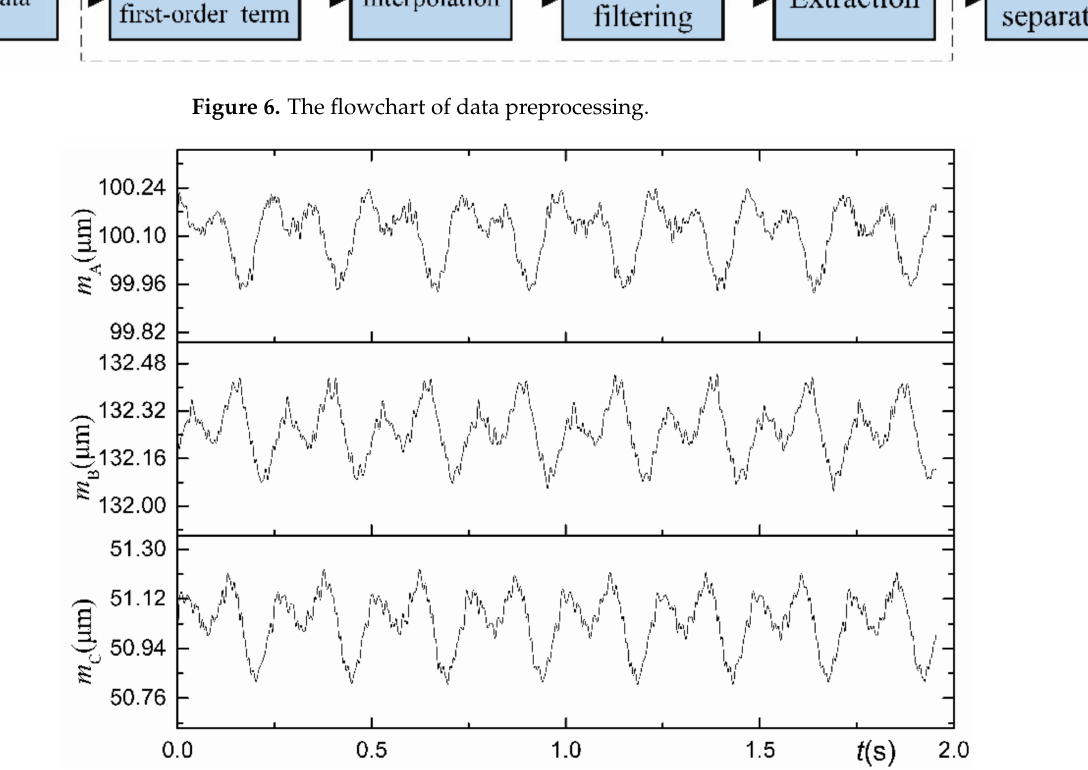
Figure 7. The preprocessed signals of the three